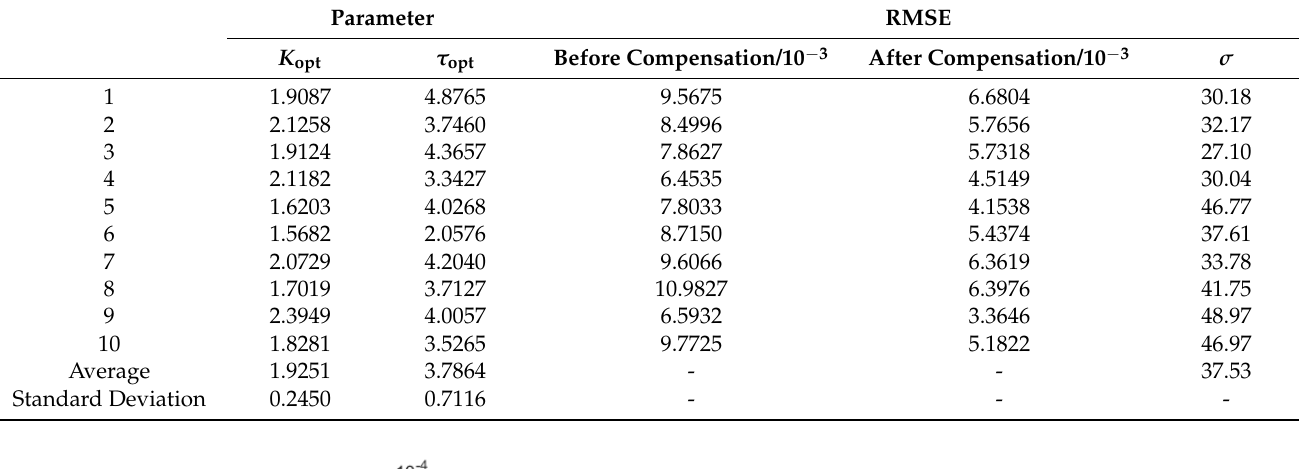
Table 1. Measurement results with ten sets of data.